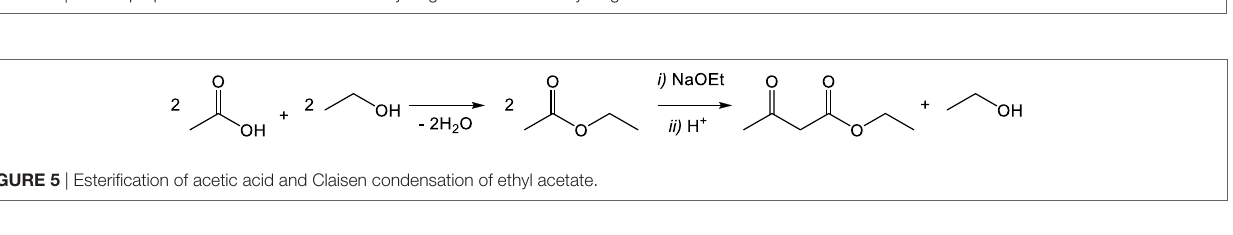
FigUre 4 | Overall preparation of acetic acid via CO 2 hydrogenation followed by Grignard reaction.